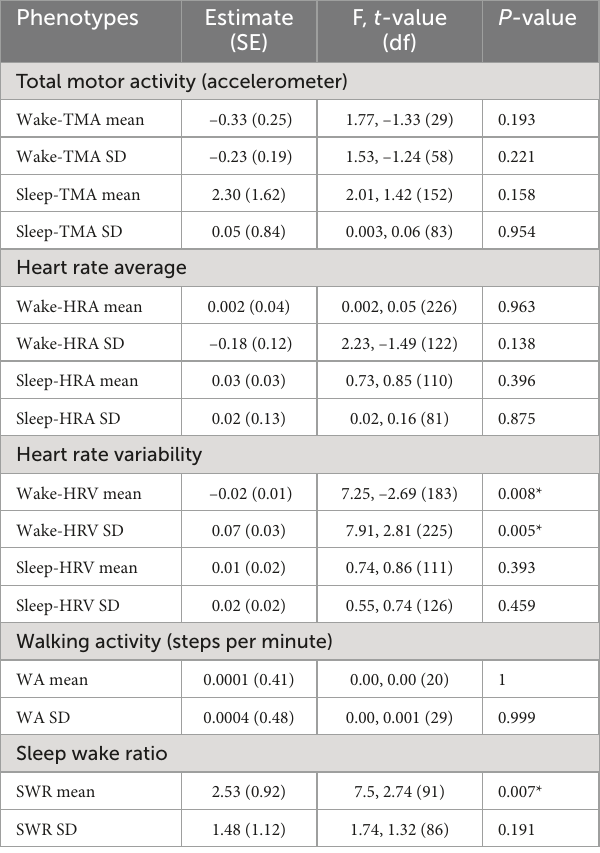
TABLE 3 Digital phenotypes predicting negative